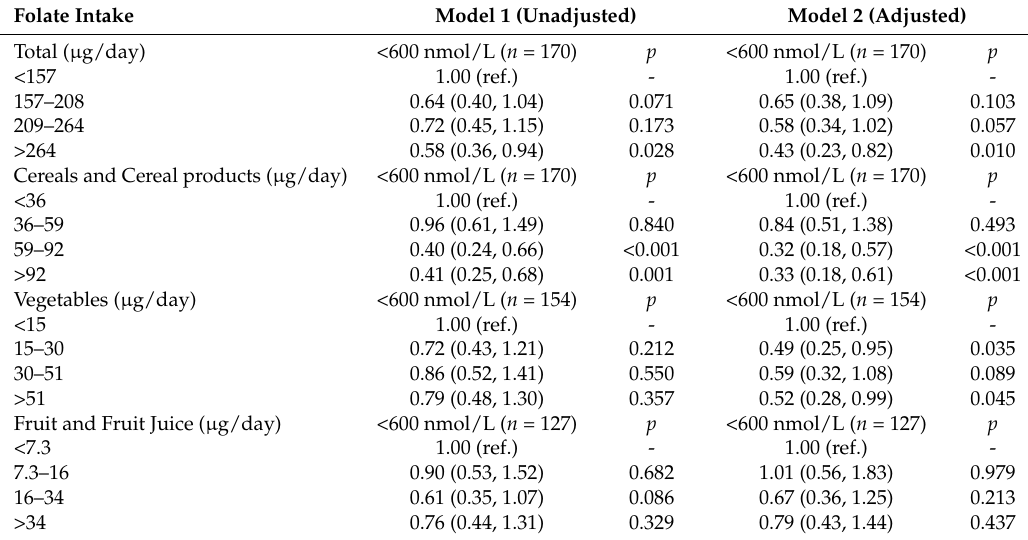
Table 3. Odds ratio (95% CI) of low RBC folate concentration according to quartiles of total folate intake and intakes from cereals and cereal products, from vegetables and from fruit and fruit juice in the Newcastle 85+